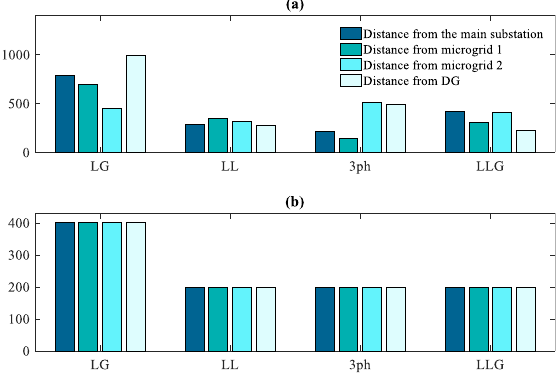
Fig. 6 ANN outputs error of estimated fault distances from all sources, for 20 randomly selected testing data